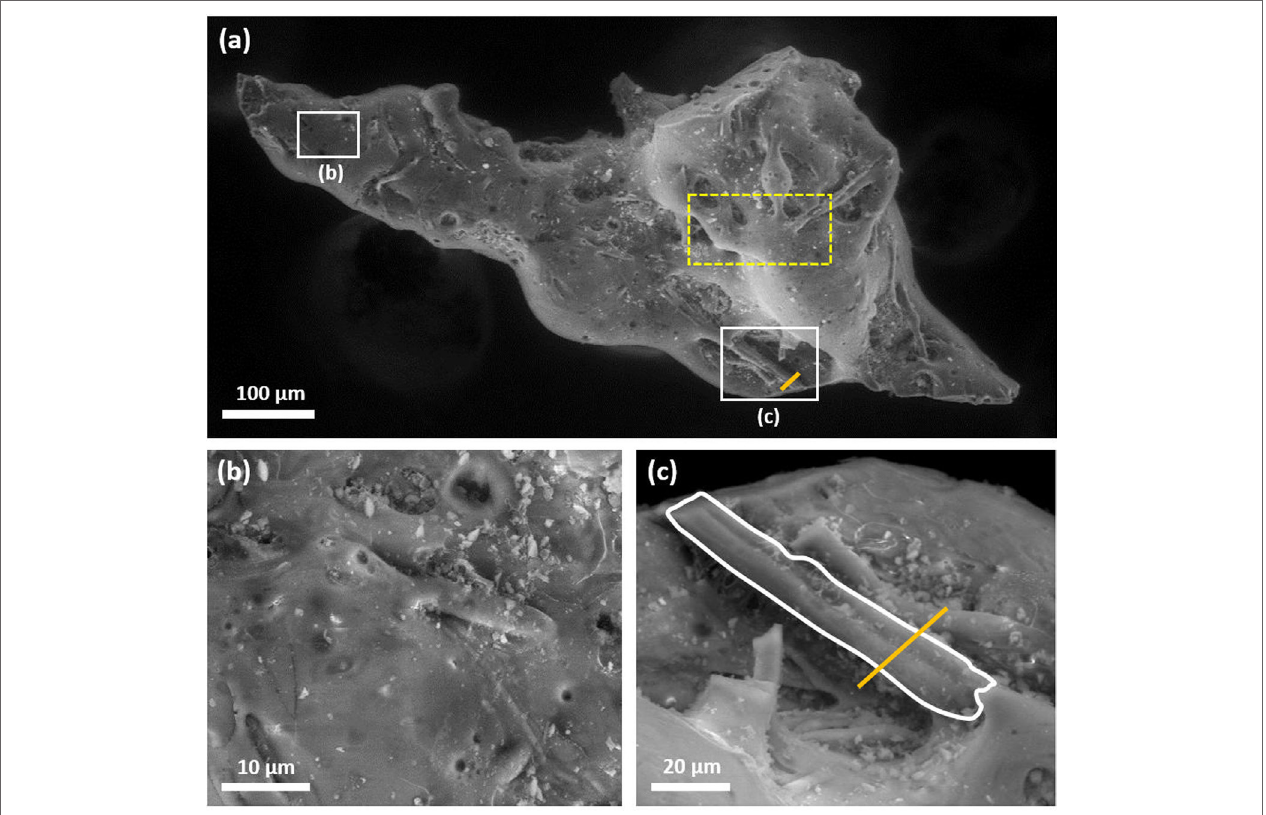
FigUre 1 | (a) Scanning electron microscope image of one of the entire submillimeter particles—apparent is its highly angular form; (B) smooth surface region showing micron and sub-micron recesses; (c) fibrous surface feature with line of section ( Figures 3a and 4 )